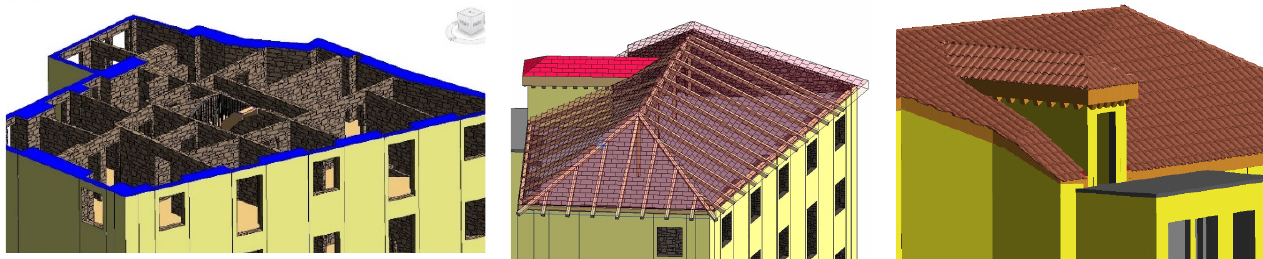
Figure 6. Model of the interior walls and roof.